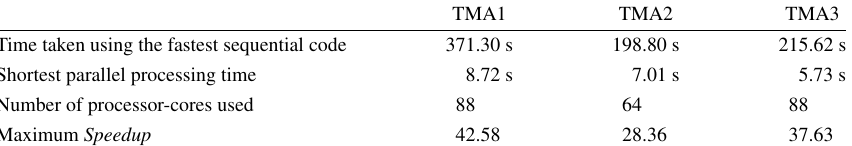
Statistics for the overall processing time for texture feature calculation including Loading , Texture and Saving from the test of the 3 TMA virtual slides